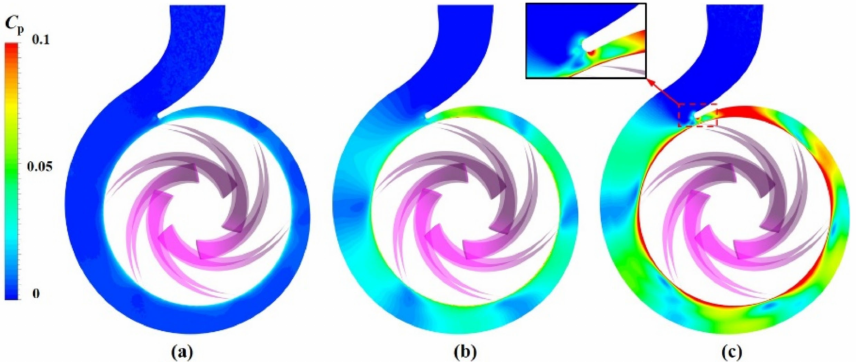
Figure 16. C p distribution under different operation conditions in the Z = 0 plane of the volute.